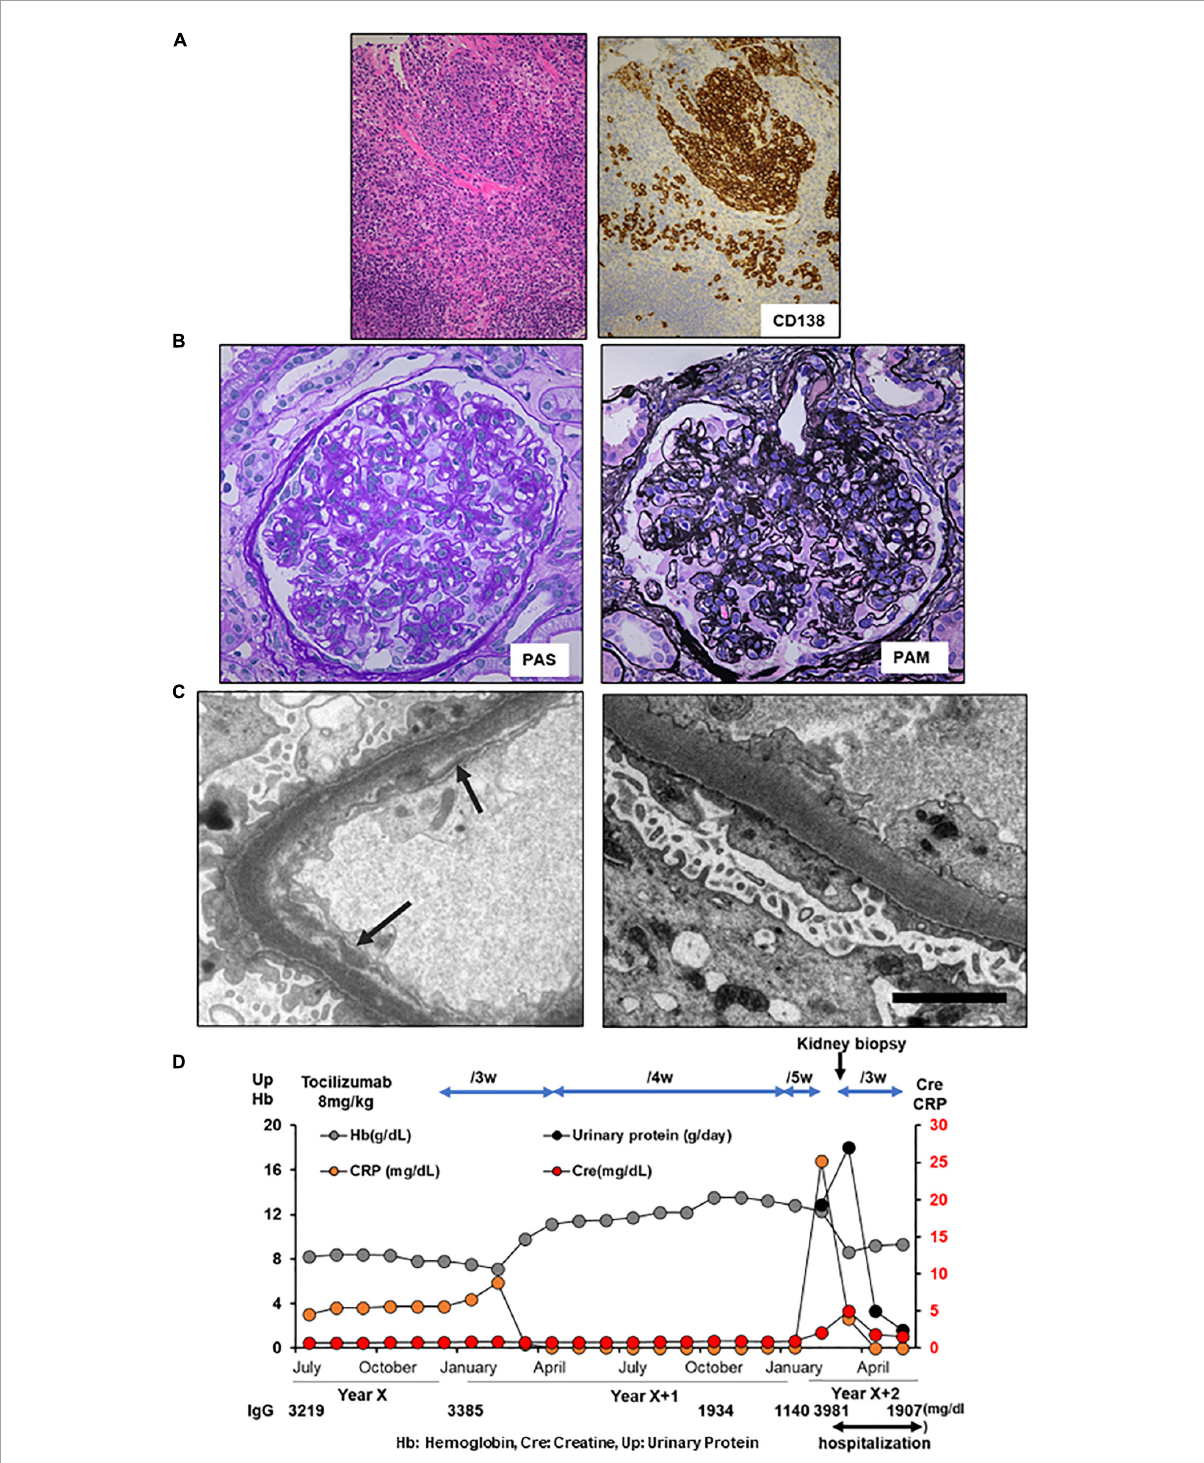
FIGURE1 Histology and time course for Case 1. (A) Light microscopy of the external iliac lymph node exhibiting follicular hyperplasia (left lower) and infiltration by CD138 + plasma cells. (B,C) Renal biopsy. (B) Light micrograph showing diffuse mesangial and endocapillary hypercellularity. (C) Electron micrograph showing subendothelial widening with neo-densa (left, silver impregnation) and glomerular basement membrane thickening (right). Arrows indicate argyrophilic neo-densa. Scale bar, 2.5 µ m. PAS: Periodic acid–Schiff. PAM: Periodic acid methenamine. (D) Clinical time course of Case 1. Hb, hemoglobin, Cre, creatine, Up, urinary